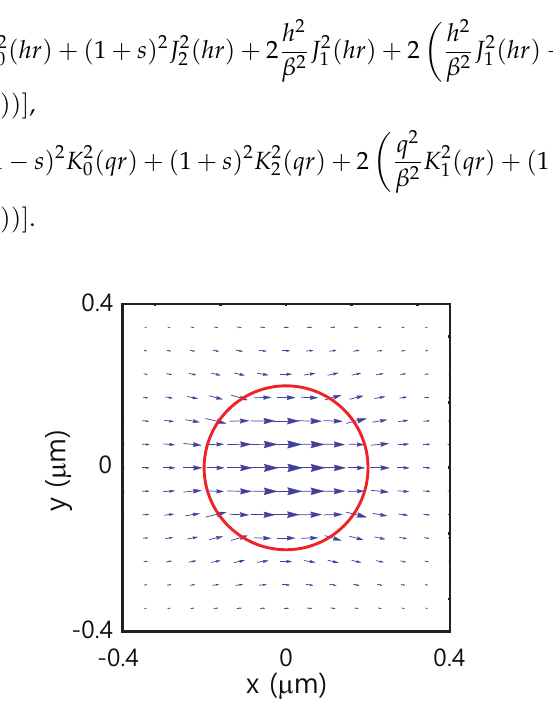
Figure 8. Vector field plot of the electric field component perpendicular to the z -axis in the fundamental HE 11 mode with φ 0 = 0 ( x -polarization). Parameters are same as used in Figure